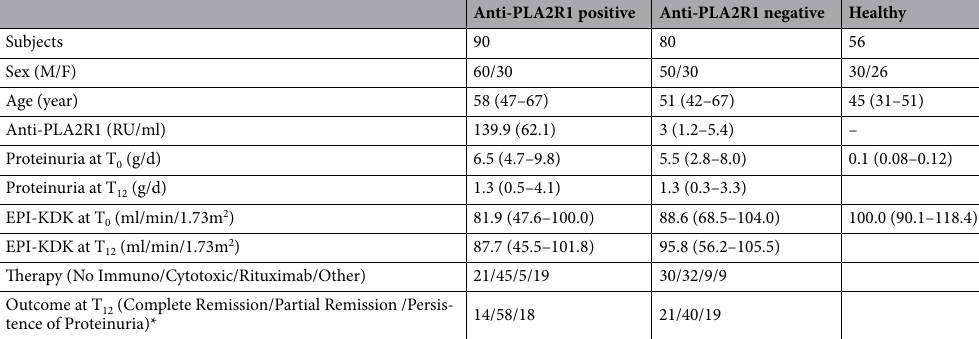
Table 1. Clinical characteristics of healthy donor and idiopathic membranous nephropathy (MN) patients utilized in the discovery and validation study. Continuous data were reported as median and interquartile range. *Complete Remission = proteinuria < 0.3 g/d; Partial Remission = proteinuria between 0.3–3.5 g/d; Persistence of proteinuria = proteinuria > 3.5 g/d. The data were reported as median and interquartile range.